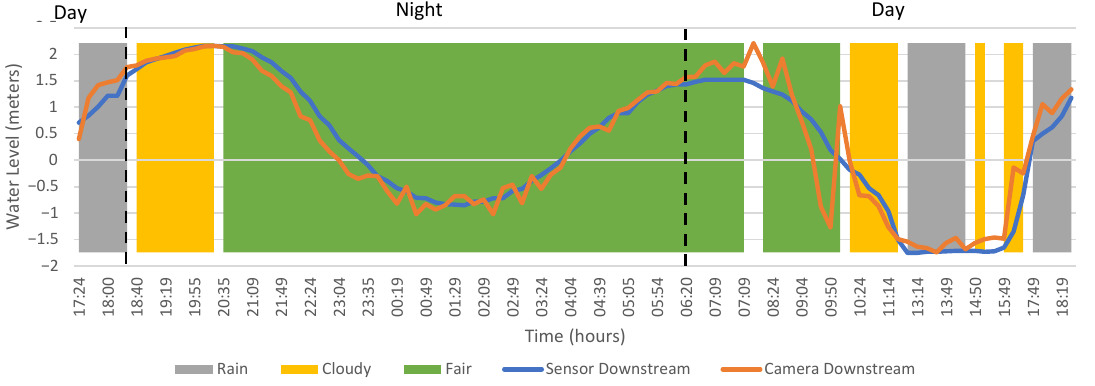
Figure 12. Water level with reference to MSL; scenario 4 displays readings under abrupt weather